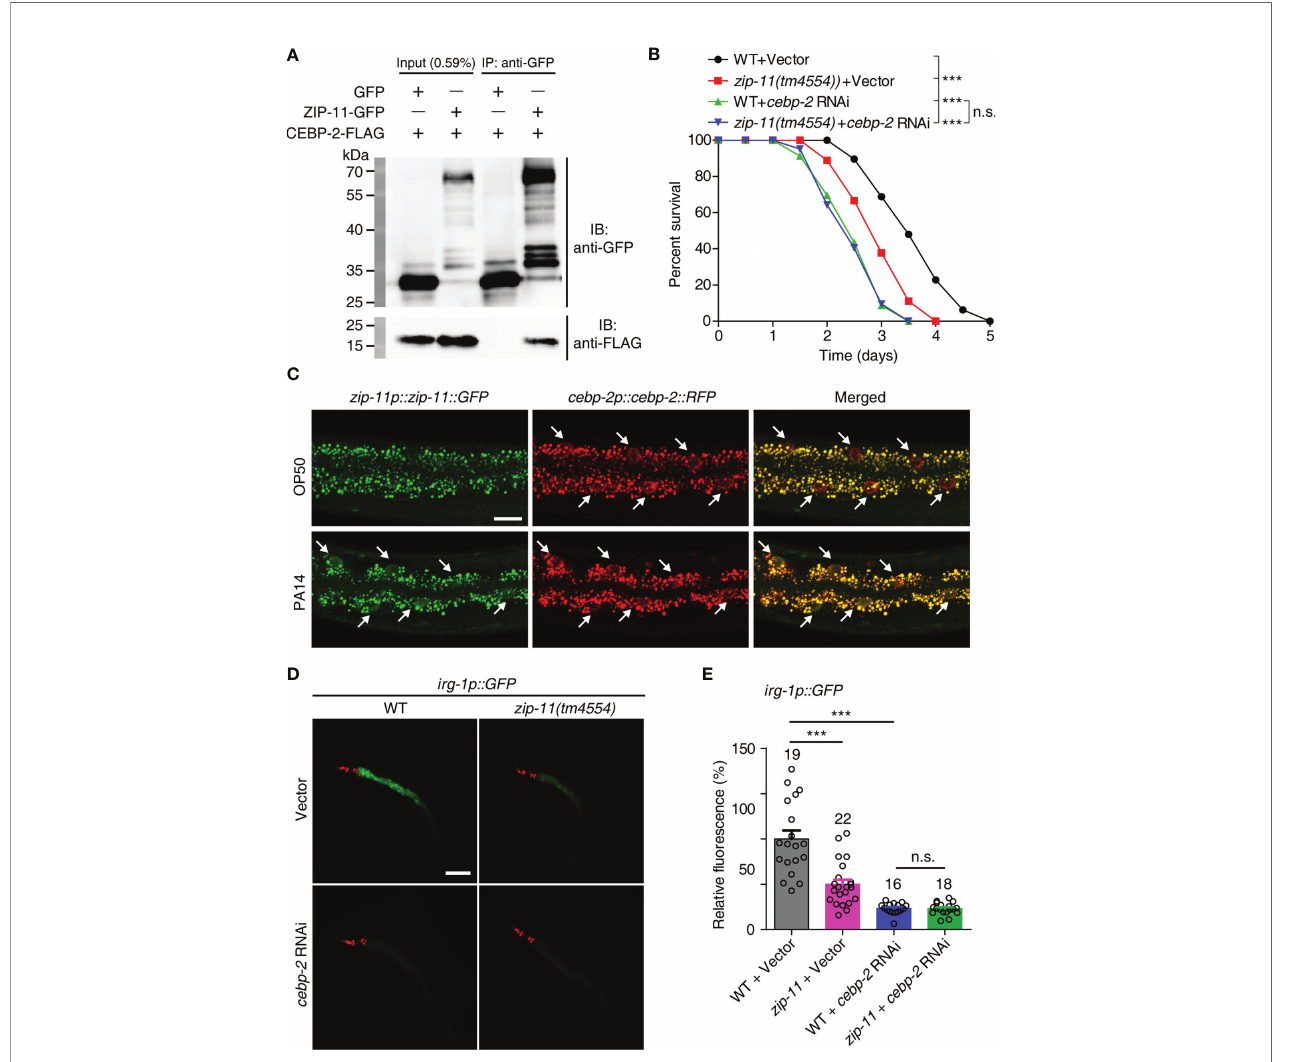
FIGURE 4 | ZIP-11 interacts with CEBP-2 to regulate immune response against P. aeruginosa infection. (A) Immunoprecipitation of ZIP-11 − GFP with anti-GFP antibodies was followed by western blot analysis with anti-Flag antibodies to detect the Flag-tagged CEBP-2. (B) WT worms and zip-11(tm4554) worms fed with vector control or cebp-2 RNAi bacteria were exposed to P. aeruginosa PA14 and scored for survival. (C) Representative images of the zip-11p::zip-11::GFP;cebp- 2p::cebp-2::RFP worms exposed to E. coli OP50 or P. aeruginosa PA14. ZIP-11::GFP or CEBP-2::RFP nuclear accumulation in the anterior portion of intestinal tissue (white arrows) are indicated. Scale bar: 20 m m. (D) Representative images of irg-1p::GFP and zip-11(tm4554);irg-1p::GFP worms fed with vector control and cebp-2 RNAi bacteria were exposed to P. aeruginosa PA14. myo-2p::mcherry shows the red fl uorescence of pharyngeal as a marker for the transgene. Scale bar: 200 m m. (E) Quanti fi cation of the GFP fl uorescence intensity using the software program ImageJ. The number of animals analysed is indicated. Data are presented as mean ± SEM. Statistical signi fi cance was determined by log-rank test (B) or Student ’ s t -test (E) . ***p < 0.001 compared with respective controls unless speci fi cally indicated; n.s., not signi fi cant. Please see Table S4 in Supplementary Material for detailed statistical analysis of killing assay